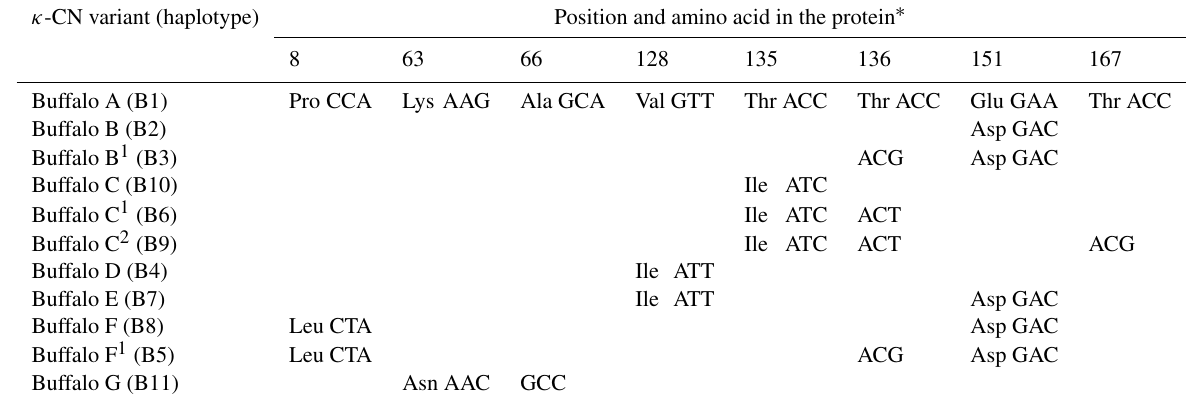
Table 5. Amino acid positions and differences in genetic variants of buffalo κ -CN. κ -CN variant (haplotype)